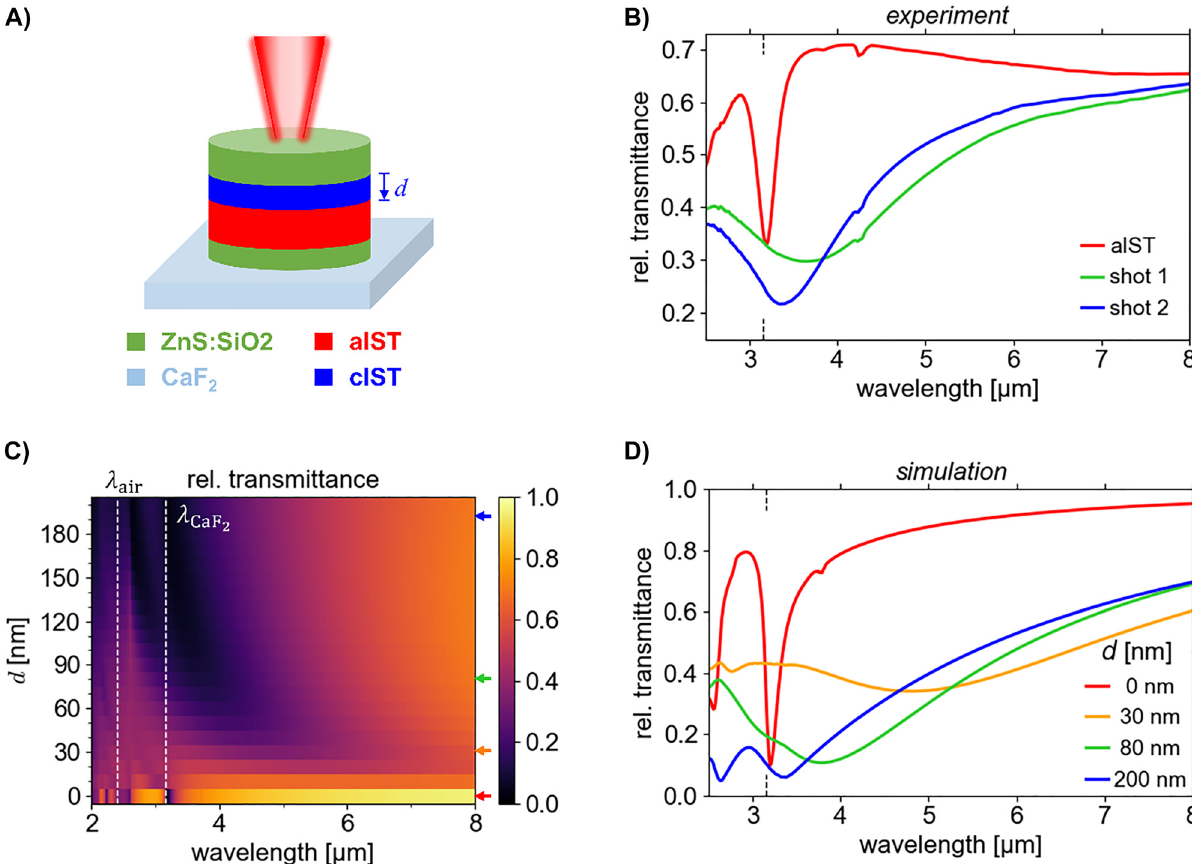
Figure 4: Crystallization depth tuning by optical switching in IST nanodisks. (A) Sketch of the layer stack of disk antennas ( D = 1.5 µm, p = 1.9 µm): by optically switching the antenna from the top with a pulsed laser, the aIST is crystallized from top-to-bottom to a crystallization depth d . Successive laser shots with increased pulse power lead to an increase of the crystallization depth d . (B) Measured transmittance spectra of aIST disk arrays (red) and the same disks after the fi rst (green) and second(blue) laser shot.(C) Simulated transmittance spectra of the disk antenna array for crystallization depths d from 0 nm (aIST) to 200 nm (cIST). The grating resonances in air and CaF 2 are marked with dashed white lines. (D) Angle-averaged simulated transmittance spectra for different crystallization depths d (also indicated by the colored arrowsinpanelC).Thegratingresonancewavelengthat3.15µmismarkedintheexperimentalandsimulatedspectrawithadashedblackline on the x